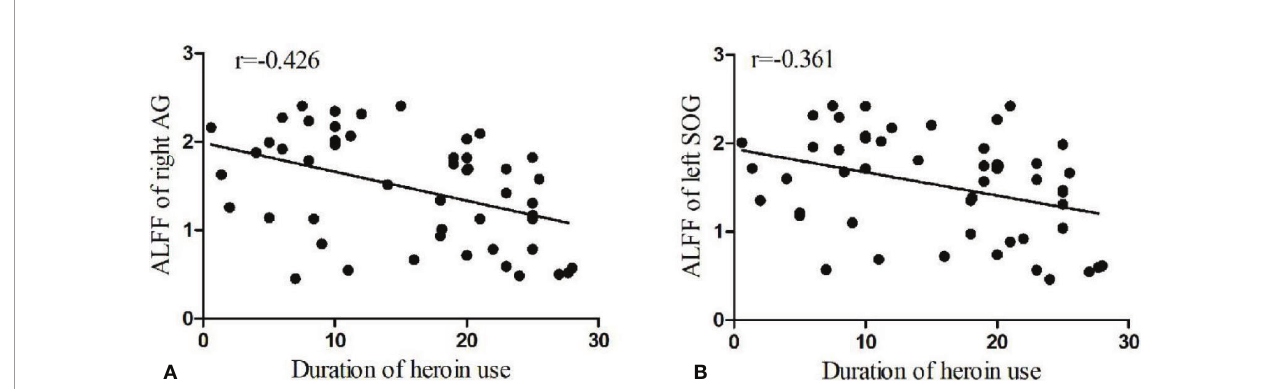
FIGURE 2 | Bivariate scatter plots. A shows the negative correlation between the duration of the heroin use and the ALFF of the right AG ( p =0.004, r =-0.426), and B the negative correlation between the duration of heroin use and the ALFF of the left SOG ( p =0.009,